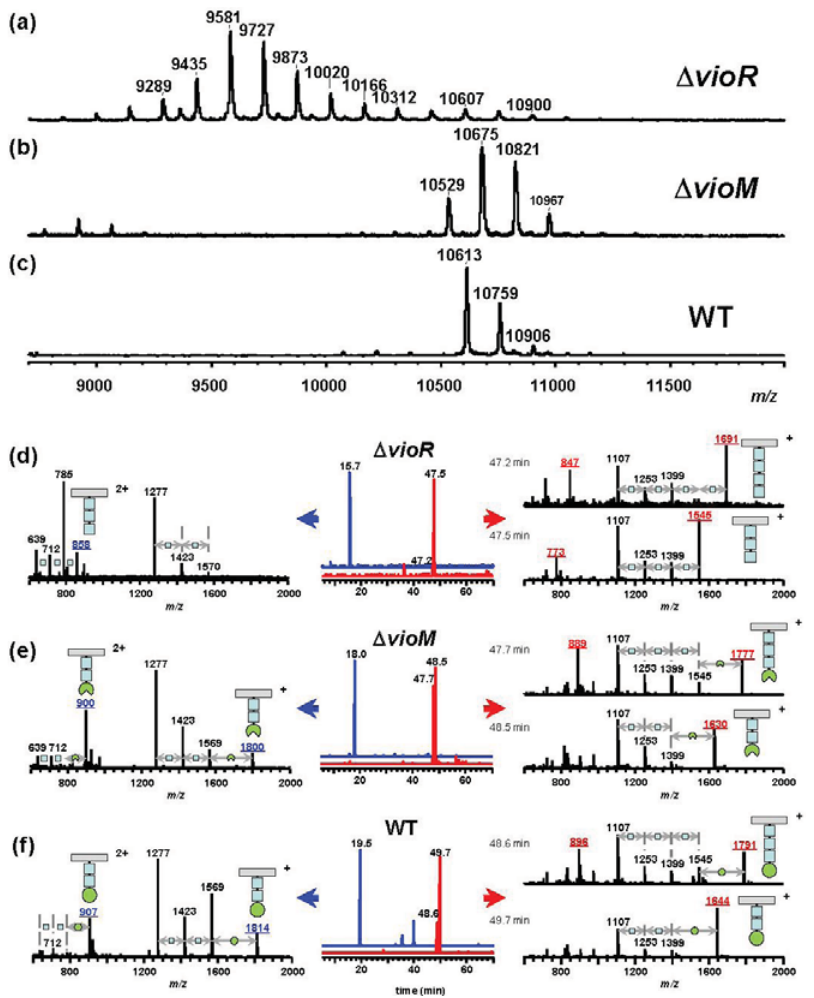
Figure 2. Mass spectra of digested flagellins of (a , d) ∆ vioR ; ( b , e ) ∆ vioM ; and ( c , f ) the WT of Pta 6605. Upper spectra ( a – c ) were of trypsin-digested flagellins by MALDI-TOF MS. The average masses of the peptide N136-R210 and the predominant trisaccharide glycan for the WT, mVio-Rha-Rha, are 7,387 and 555.5, respectively. The mVio-lacking glycan is composed of rhamnose whose residue has a mass of 146 in glycan chains. The mutant lacking vioR showed many regularly spaced peaks at the head of the list at m/z 9,581 ( (cid:1129) 7,387 + (146) × 15 + 1). The protonated ions of the glycopeptides including six glycans were observed at m/z 10,613 (7,387 + (537.5) × 6 + 1) for the WT and m/z 10,529 (7,387 + (523.5) × 6 + 1) for ∆ vioM strains. The accompanied ions with 146 and 292 larger mass values are of glycopeptides with one and two tetrasaccharide glycans out of six glycans, respectively. The lower spectra ( d – f ) were of Asp- N -digested flagellins by LC-ESI/MS. The middle column shows extracted ion chromatograms of m/z 1,277 (in red) and 1,107 (in blue) corresponding to the mass values of amino acid sequences D200-A211 and E189-I199, respectively. In the mass spectra (left and right columns), underlined mass values are of [M+H] + and [M+2H] 2+ of molecular-related ions, and the graphical assignments are as follows: grey rectangle: peptide; blue square: Rha; green circle: mVio; and notched circle: demethylated mVio. The symbol “ + ” or “ 2+ ” means the ion is singly charged or doubly charged,